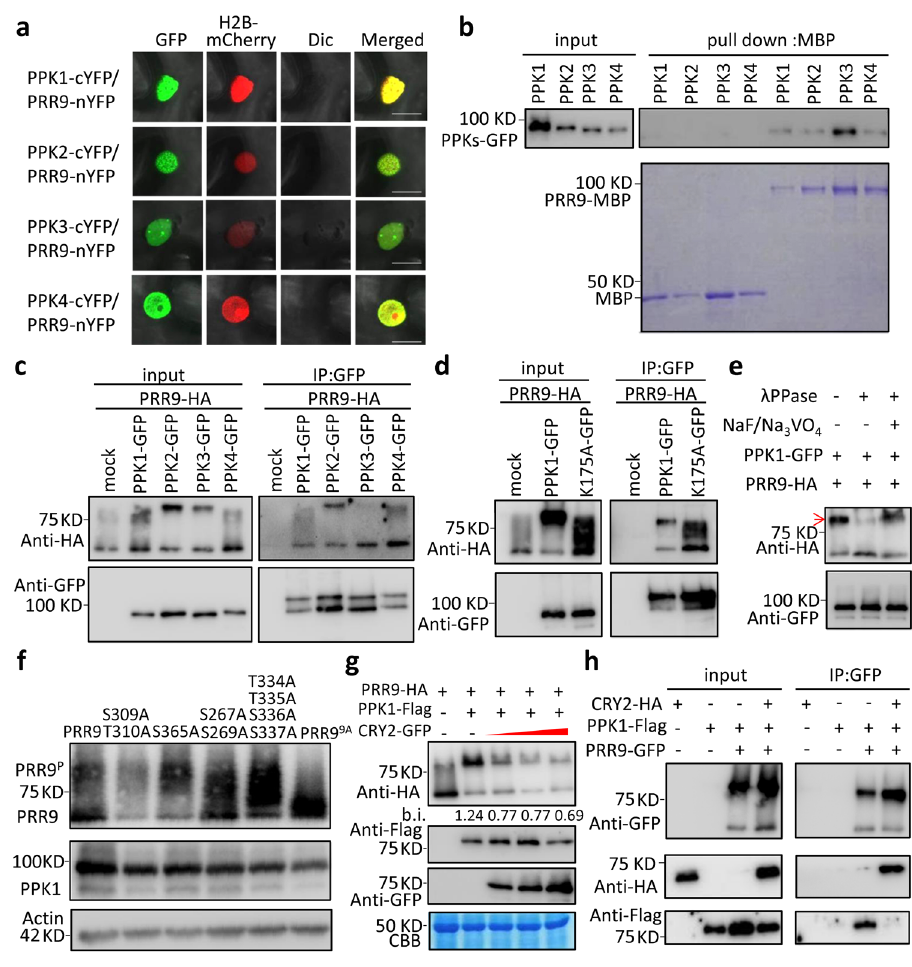
Fig. 5 | CRY2 inhibits PPKs-promoted phosphorylation of PRR9. a BiFC assay showingallPPKs(PPK1,PPK2,PPK3,andPPK4)interactedwithPRR9inthenucleus. PPKs-cYFP, were individually co-expressed with PRR9-nYFP or nYFP in N. ben- thamiana leaves. H2B-mCherry as a nucleus marker. Bars, 20 μ m. ( n =12, 12, 10, 12 cells/2 leaves) b In vitro pull down of MBP or PRR9-MBP with PPKs-GFP protein. Pulled-down complexes were detected with GFP antibody, whereas MBP or PRR9- MBP were stained by CBB. c Co-IP assay showing PPKs-GFP interacted with PRR9- HAin N.benthamiana .TheIPed(PPKs)andco-IPedsignals(PRR9)weredetectedin immunoblots probed with GFP and HA antibodies, respectively. d Co-IP assay showing an interaction between PRR9-HA with PPK1 and PPK1 K175A -GFP. The IPed (PPK1 and PPK1 K175A ) and co-IPed signals (PRR9) were detected in immunoblots probed with GFP and HA antibodies, respectively. e λ PPase treatment of PRR9-HA with PPK1-GFP co-expressing N. benthamiana protein lysates. The red arrow